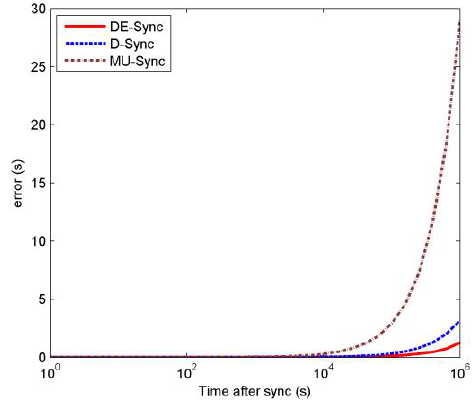
Figure 9. Clock error vs. time after sync.